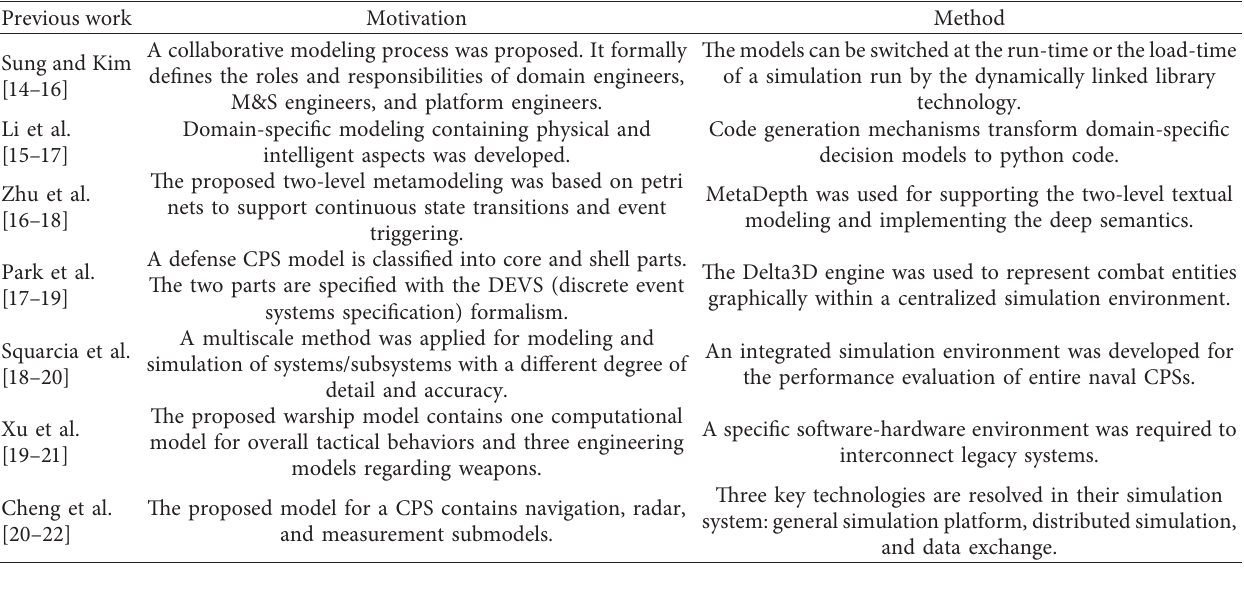
Table 1: Related works for modeling and simulation studies of defense cyber-physical